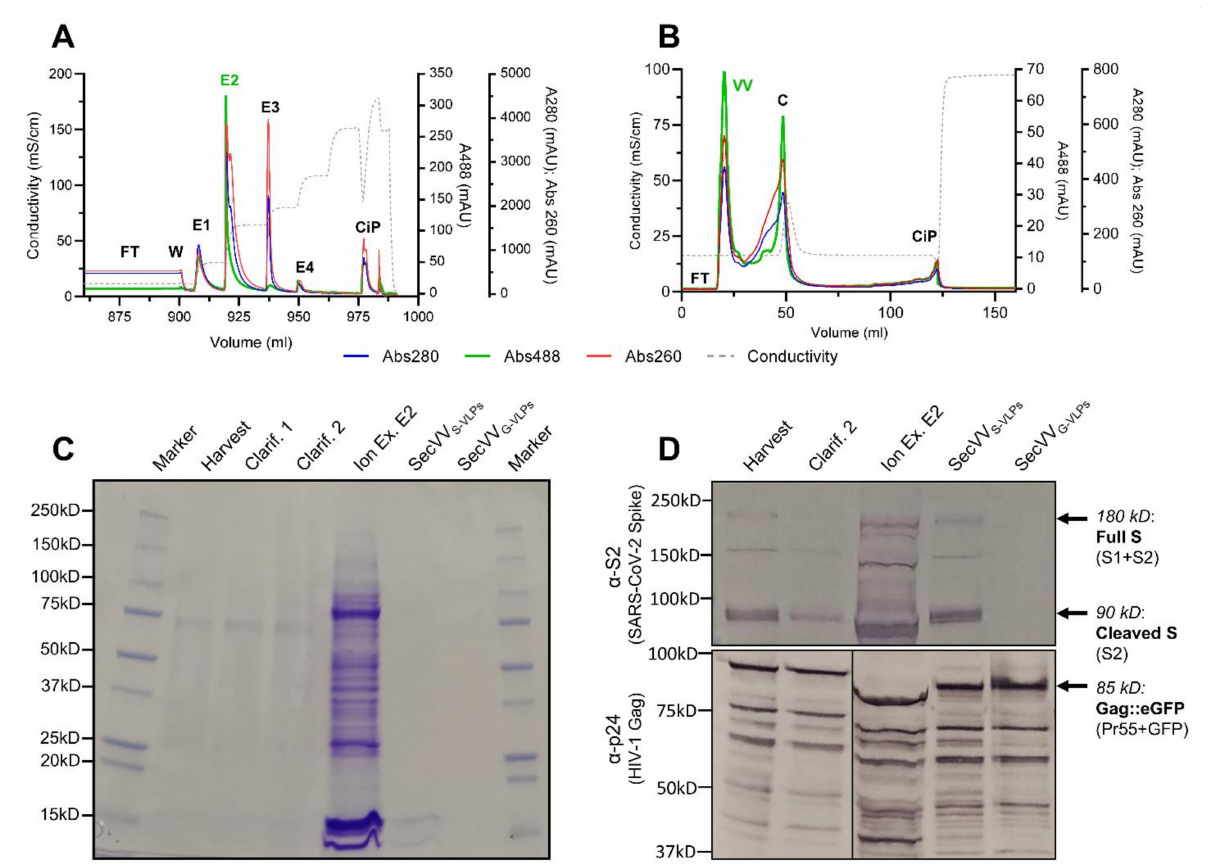
Figure 5. ( A ): Ion-exchange capture step chromatogram: FT (flow through), W (wash), E1-4 (eluted fractions resulting from different conductivity step increases, with E2 being the IEX purified product), CiP (cleaning in place). ( B ): Size-exclusion polishing-step chromatogram: FT (flow through), VV (void volume, which is the final SEC-purified product), C (contaminants and aggregates), CiP (cleaning in place). ( A , B ): Blue line: absorbance at 280 nm, indicating protein presence. Red line: absorbance at 260 nm, indicating DNA presence. Green line: absorbance at 488 nm, indicating Gag::eGFP presence. Dotted grey line: conductivity. ( C ): SDS-Page of samples collected after each purification step: harvest, primary clarification, secondary clarification, ion exchange E2 fraction and size-exclusion VV fraction. A total protein concentration increase can be observed after the IEX step, caused mostly by undesired protein contaminants. As can be observed, those proteins are successfully eliminated after the following SEC polishing step. ( D ): Western blot of samples after purification steps. Top: Membrane was treated with an anti-SARS-CoV-2 S2 spike subunit polyclonal antibody, followed by a